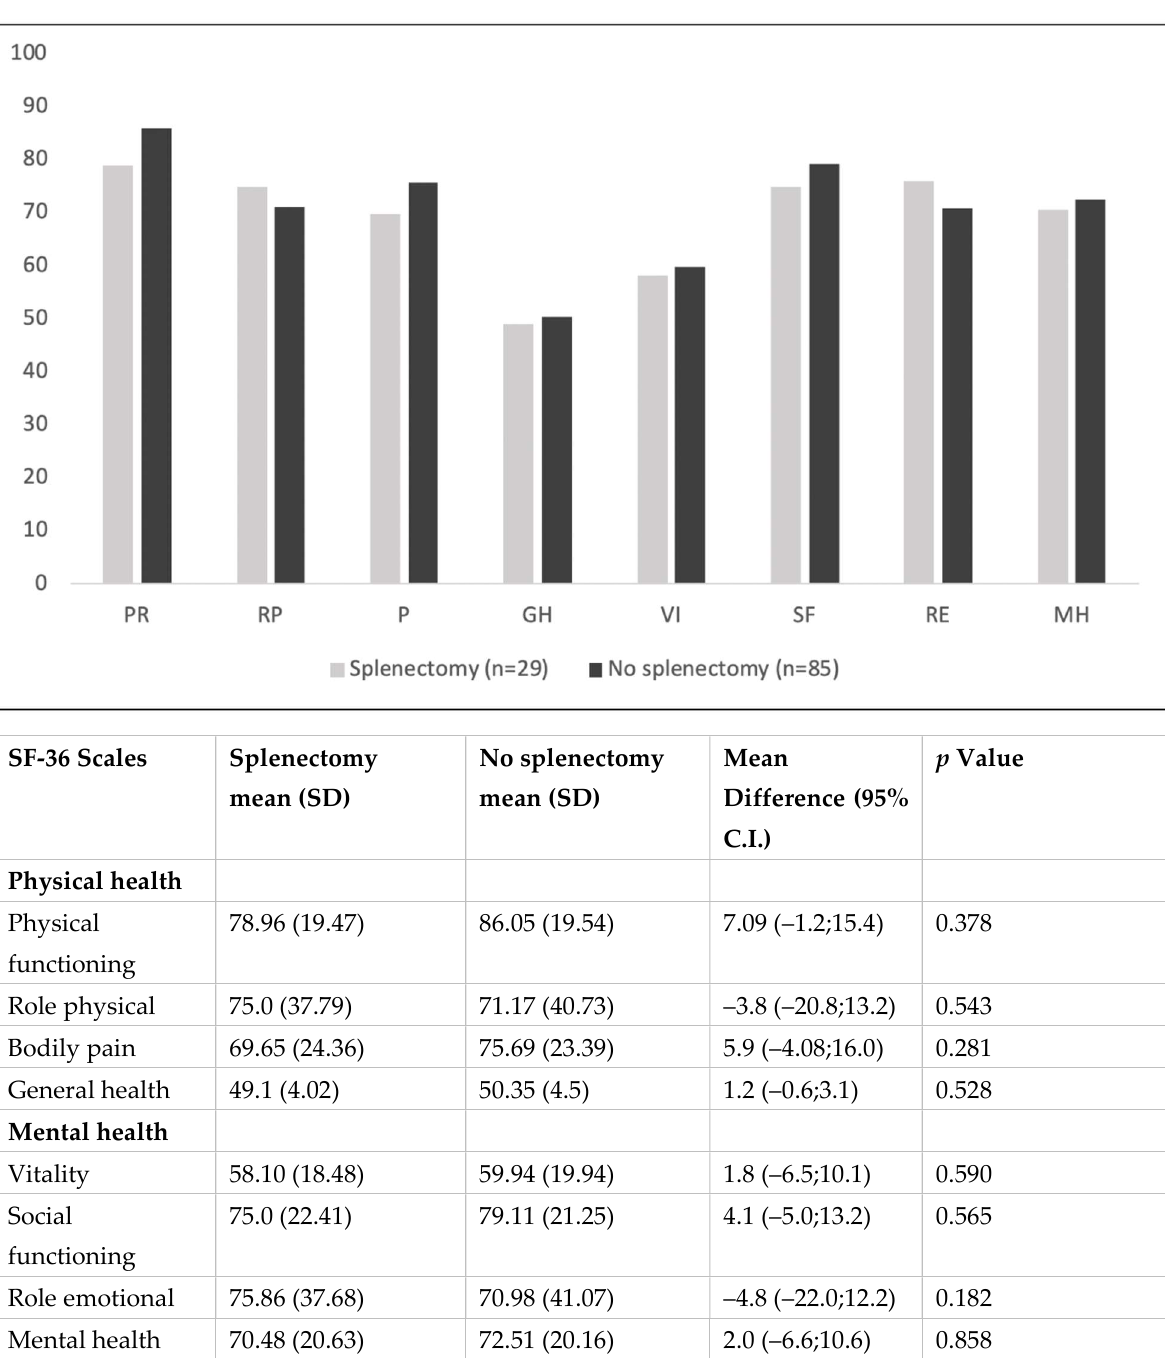
Figure 1. Graphical comparison of SF-36 scales mean scores between splenectomized and not- splenectomized β-TM patients. List of abbreviations: PF, physical functioning; RP, role physical; p , bodily pain; GH, general health; VI, vitality; SF, social functioning; RE, role emotional; MH, mental health.